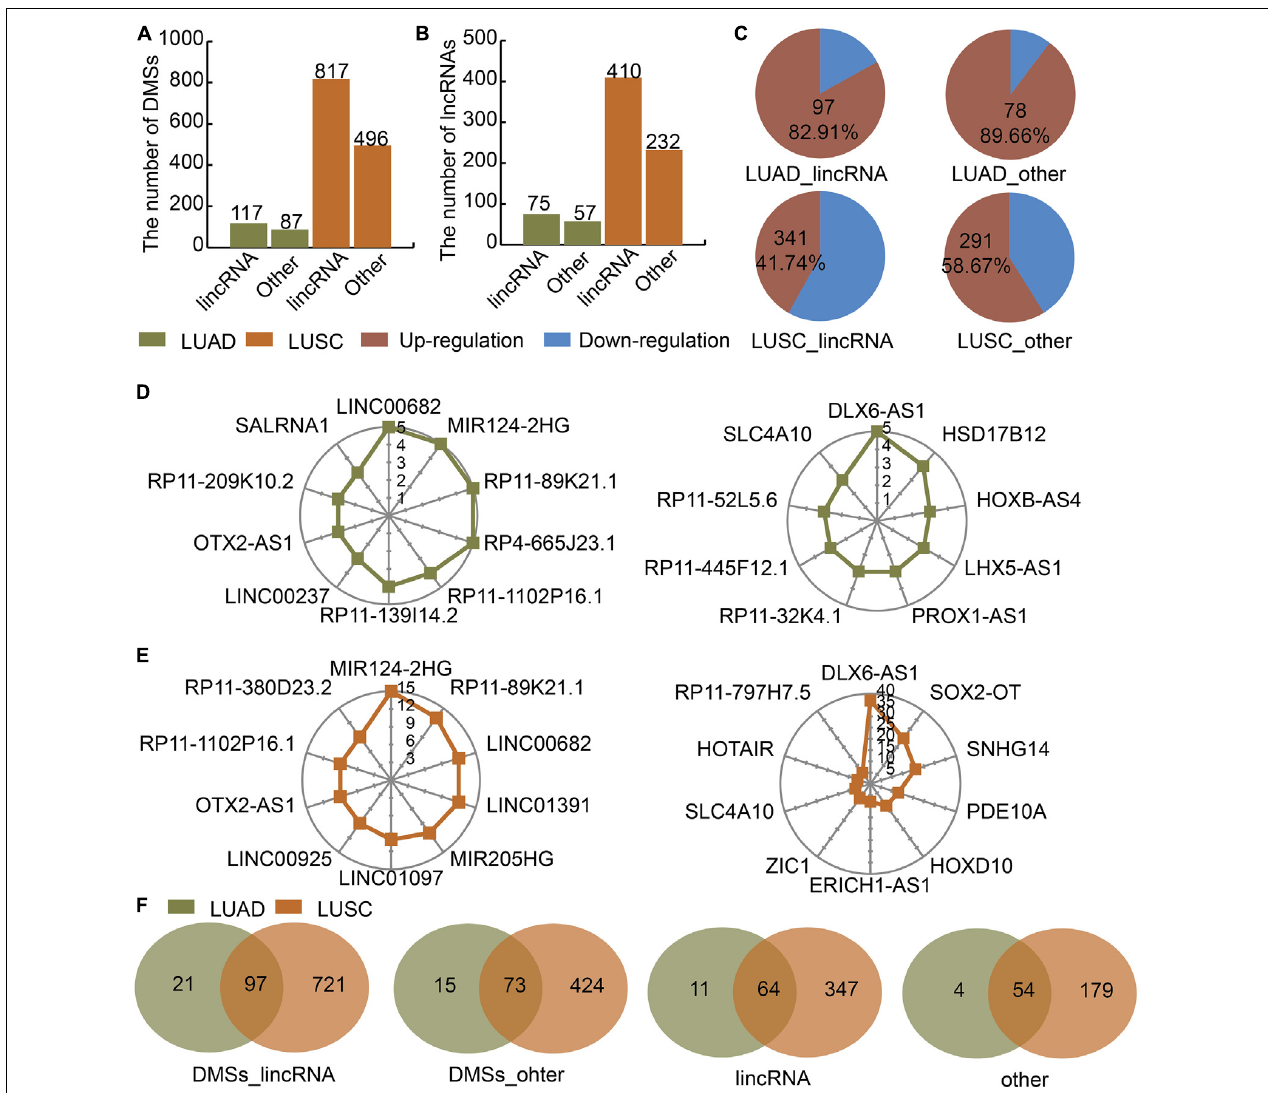
FIGURE 1 | Identification of DMSs and their corresponding DMSmlncRNAs in LUAD and LUSC. (A) Barplot showing the number of DMSs in LUAD (green) and LUSC (orange). (B) Barplot showing the number of DMSmlncRNAs in LUAD and LUSC. (C) Pie charts showing the percentages of up- (red) and downregulated (blue) DMSs in lincRNAs and other lncRNAs in LUAD and LUSC. (D) Radar maps showing the top DMSmlncRNAs with the highest numbers of DMSs in LUAD. (E) Radar maps showing the top DMSmlncRNAs with the highest numbers of DMSs in LUSC. (F) Venn diagrams showing common DMSs in genes encoding lincRNAs and other lncRNAs in LUAD (green) and LUSC (orange).